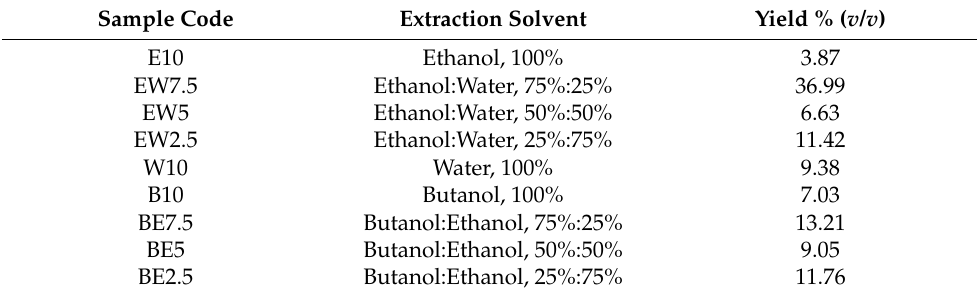
Table 1. Solvent systems used for the extraction and extraction